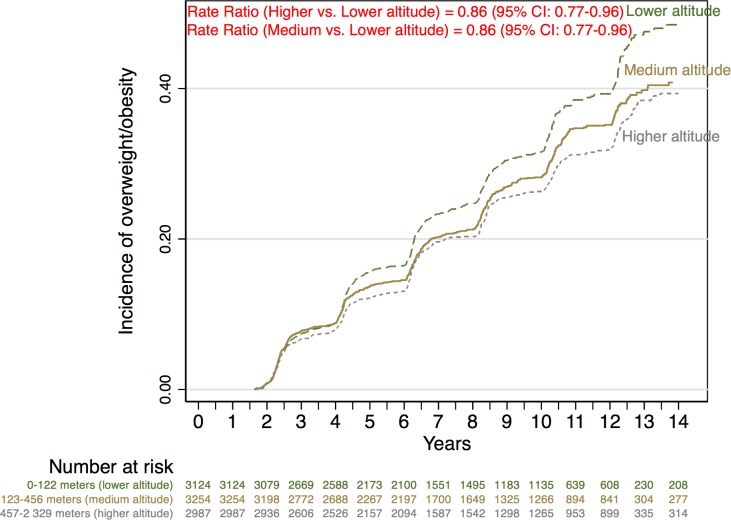
Nelson–Aalen cumulative hazard estimates.